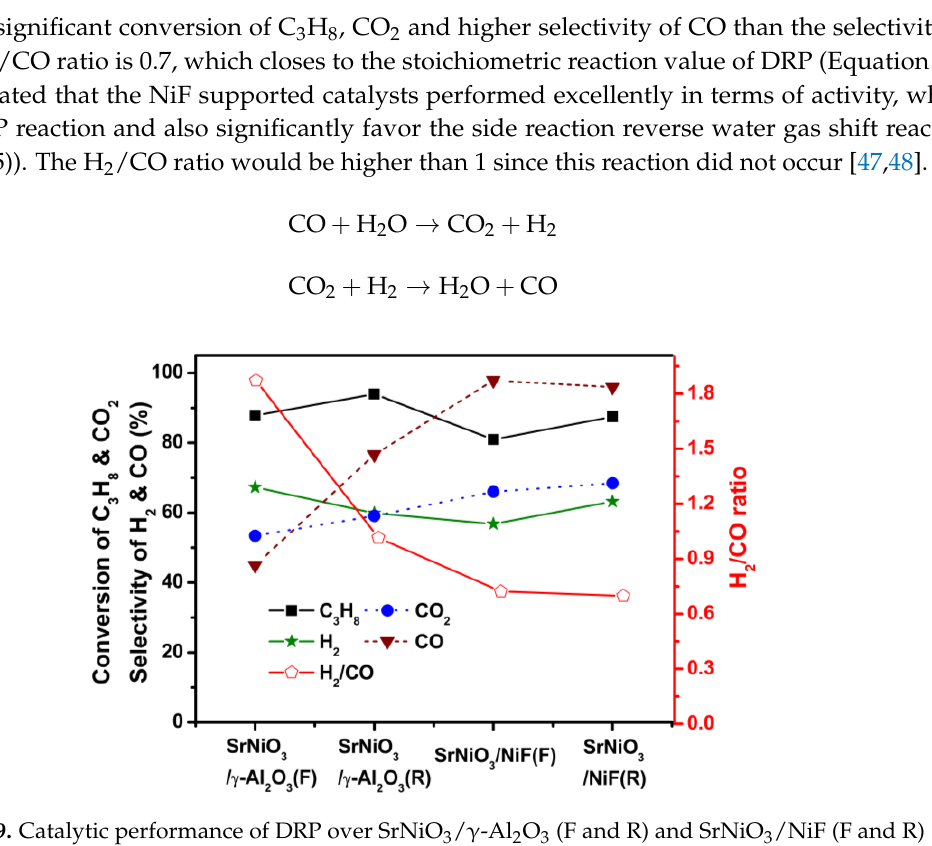
/ γ- Al O (F and R) and SrNiO 3 /NiF (F and R) catalysts at 700 °C, 3 2 3